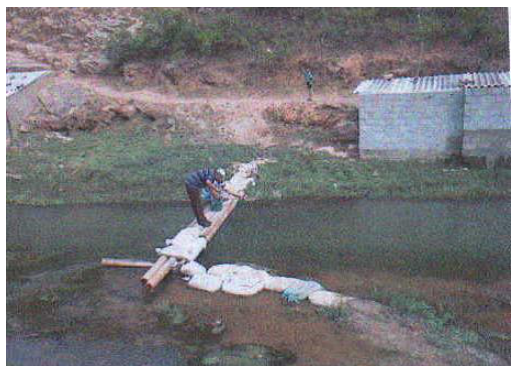
Figure 13. Automatic sampler at resurgence number two located downstream of Hammam Grouz dam